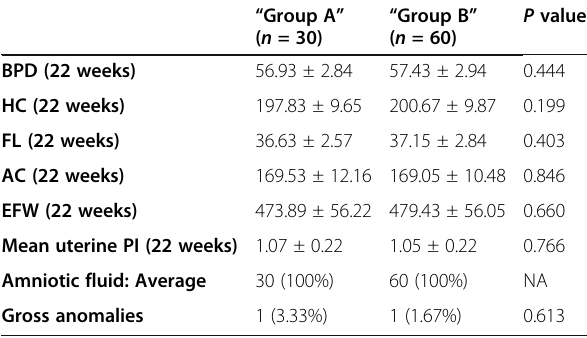
Table 2 Fetal assessment at 22 weeks of gestation in both groups